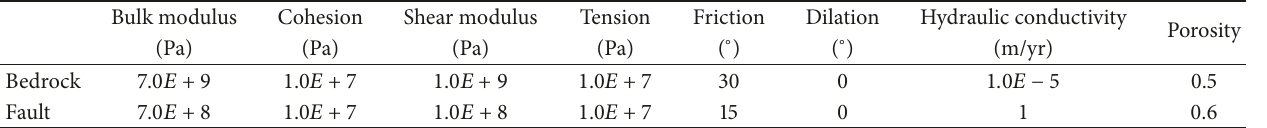
Table 1: Parameters for Models I and